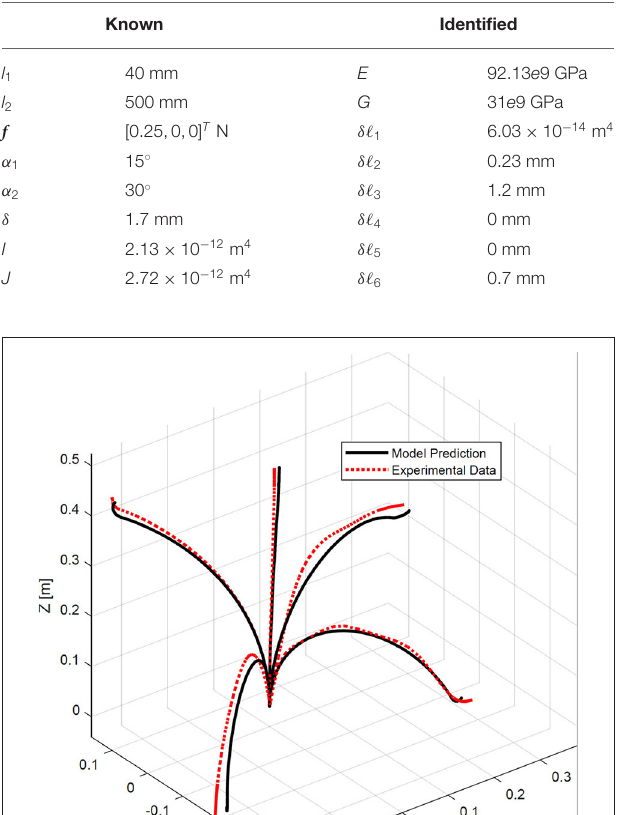
Frontiers in Robotics and AI |